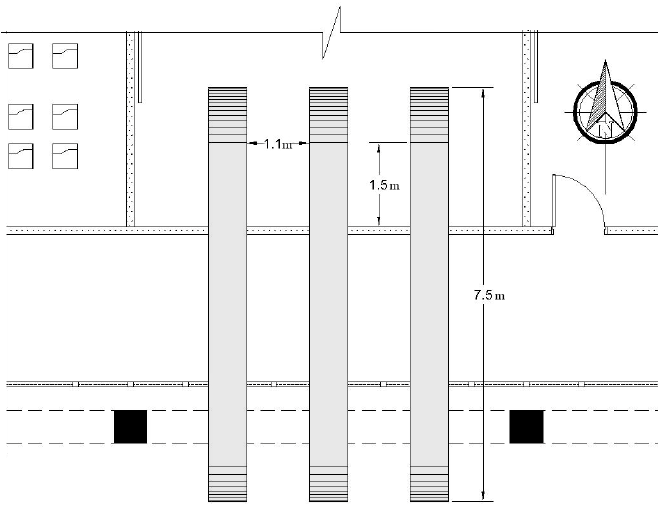
Figure 11. Ceiling plan of a typical classroom showing the suggested southern anidolic duct.